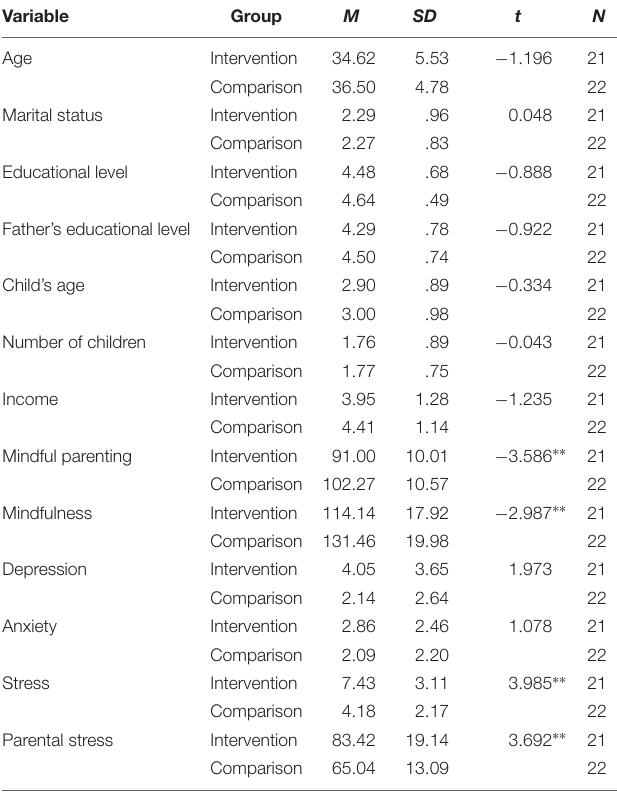
TABLE 1 | Pre-intervention means and standard